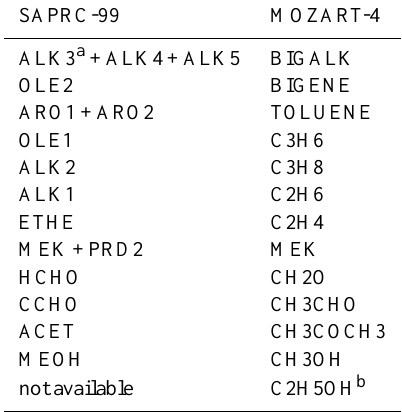
Table 4. Spatial proxies used in this work.